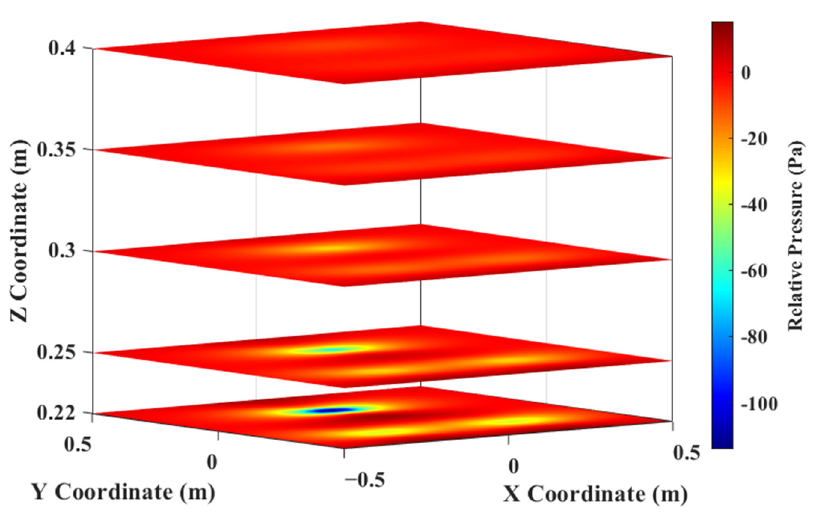
Figure 14. Relative pressure nephograms of CFD with boundary condition of 90°, 15 m/s.